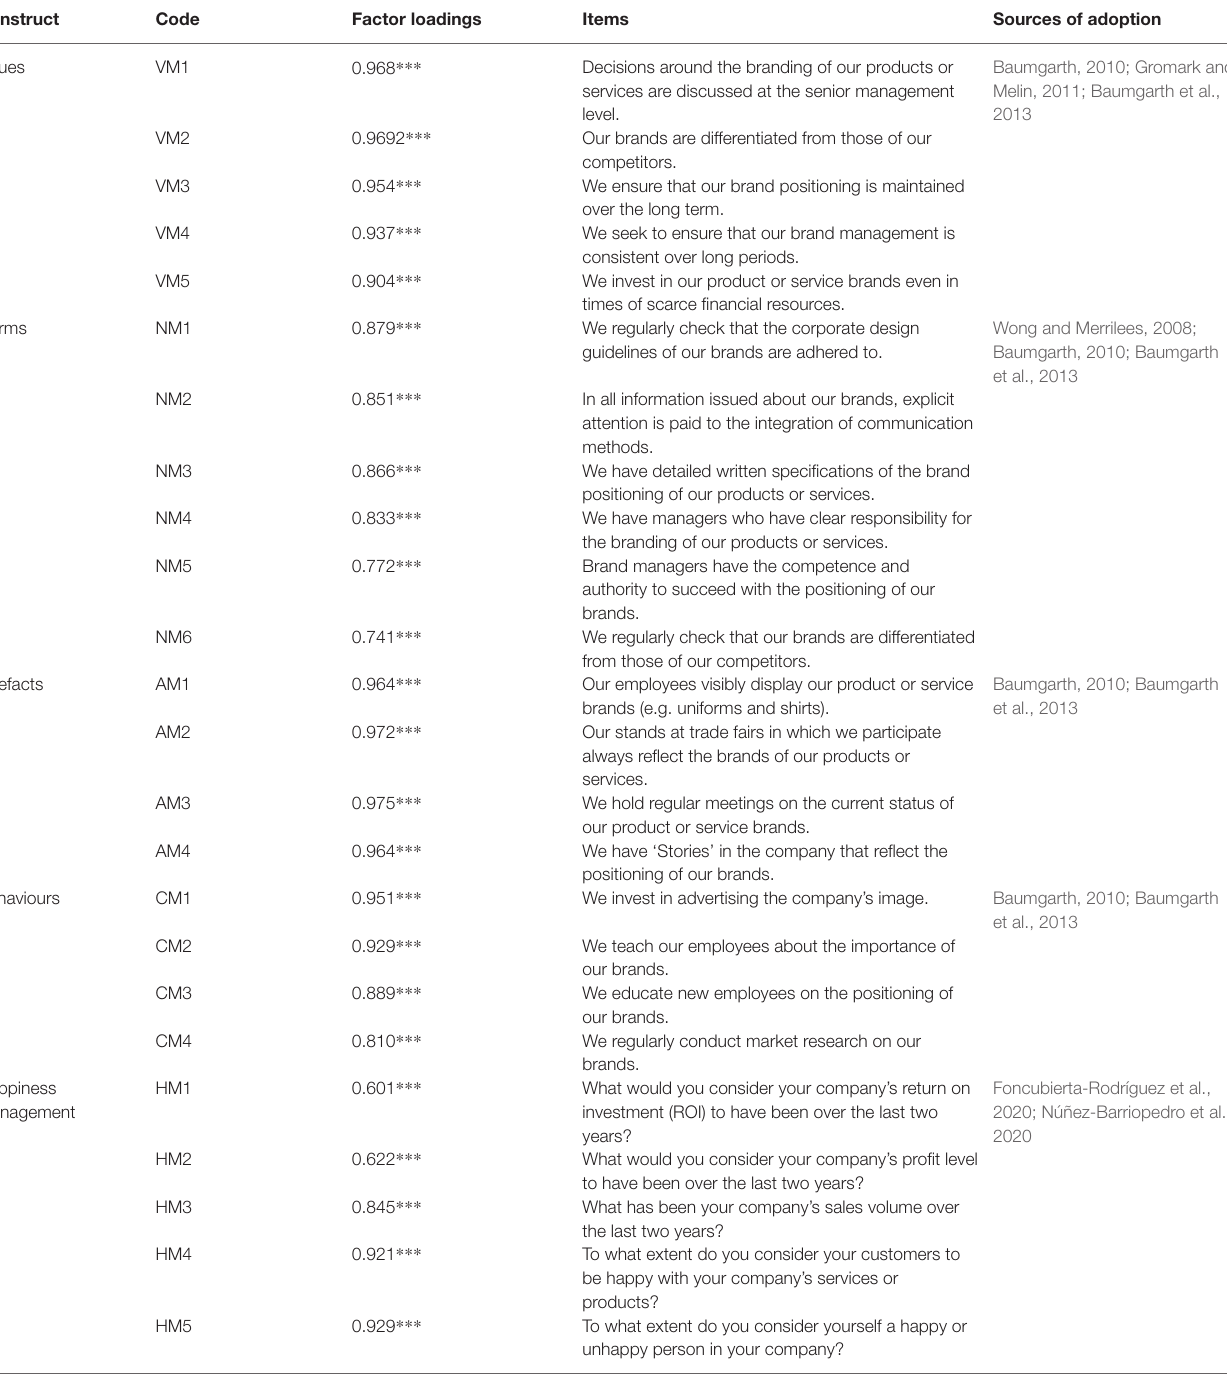
TABLE 3 | Measurement models of constructs, items and factor loadings. Construct Code Factor loadings Items Sources of